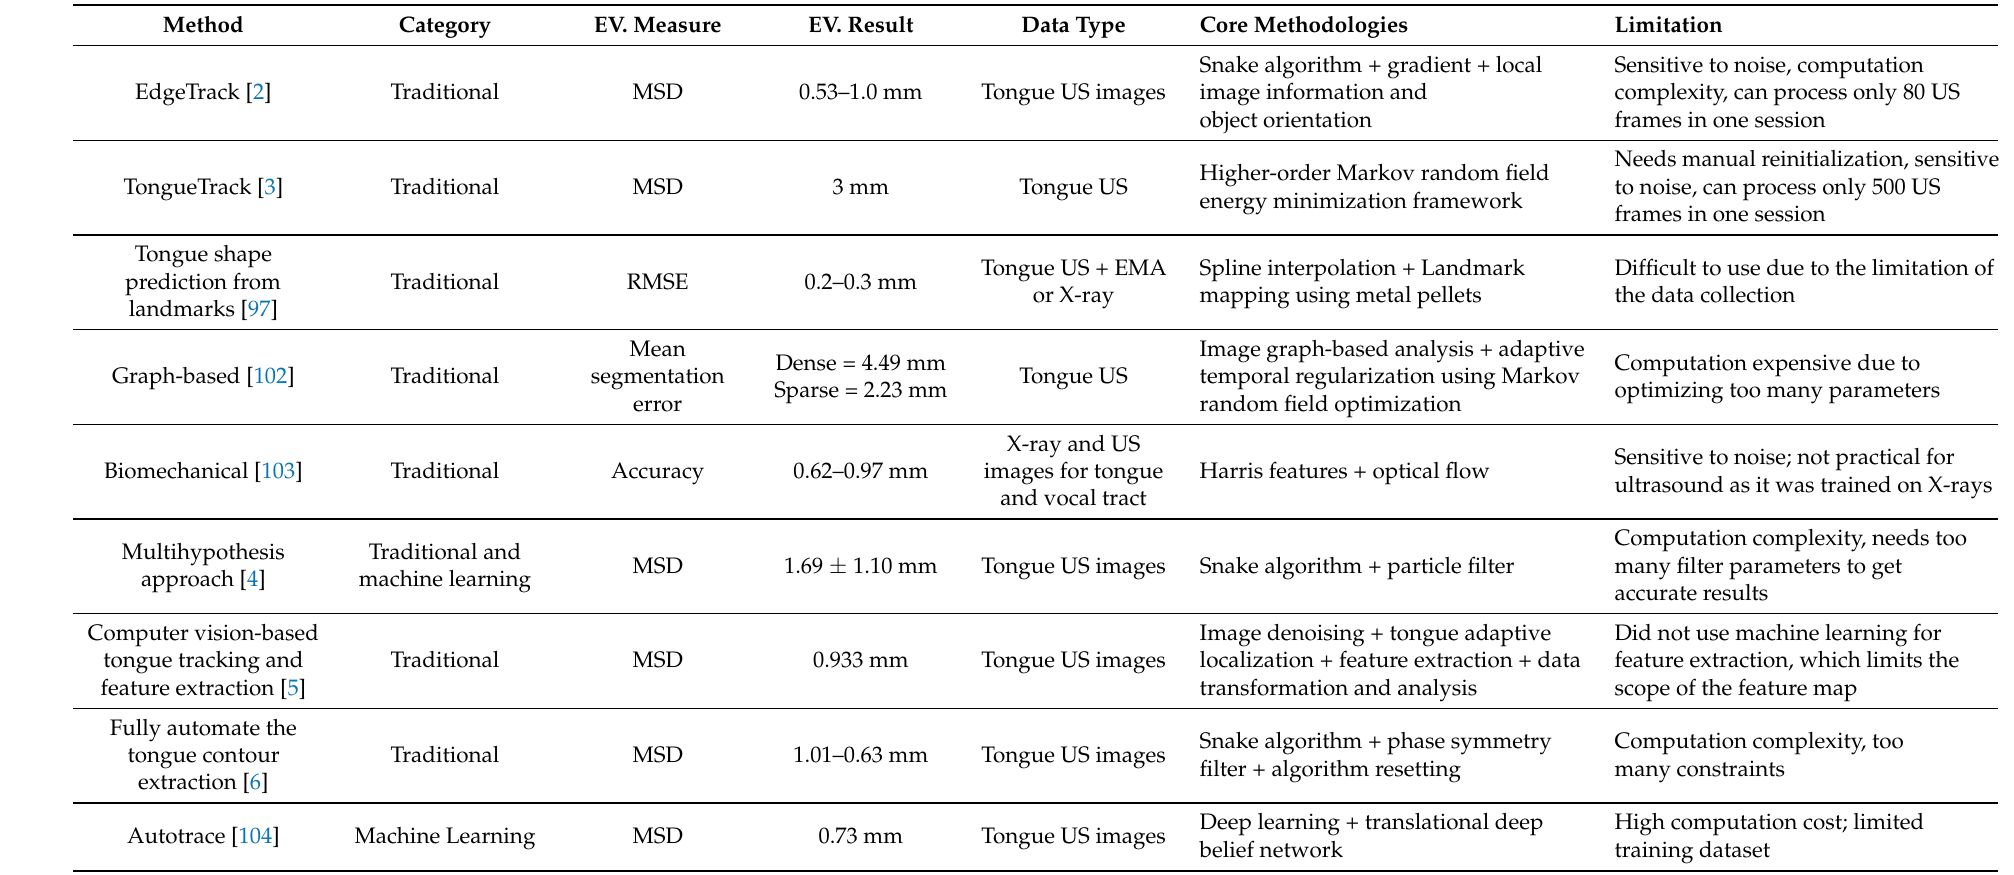
Table 1. Comparison between different tongue contour segmentation